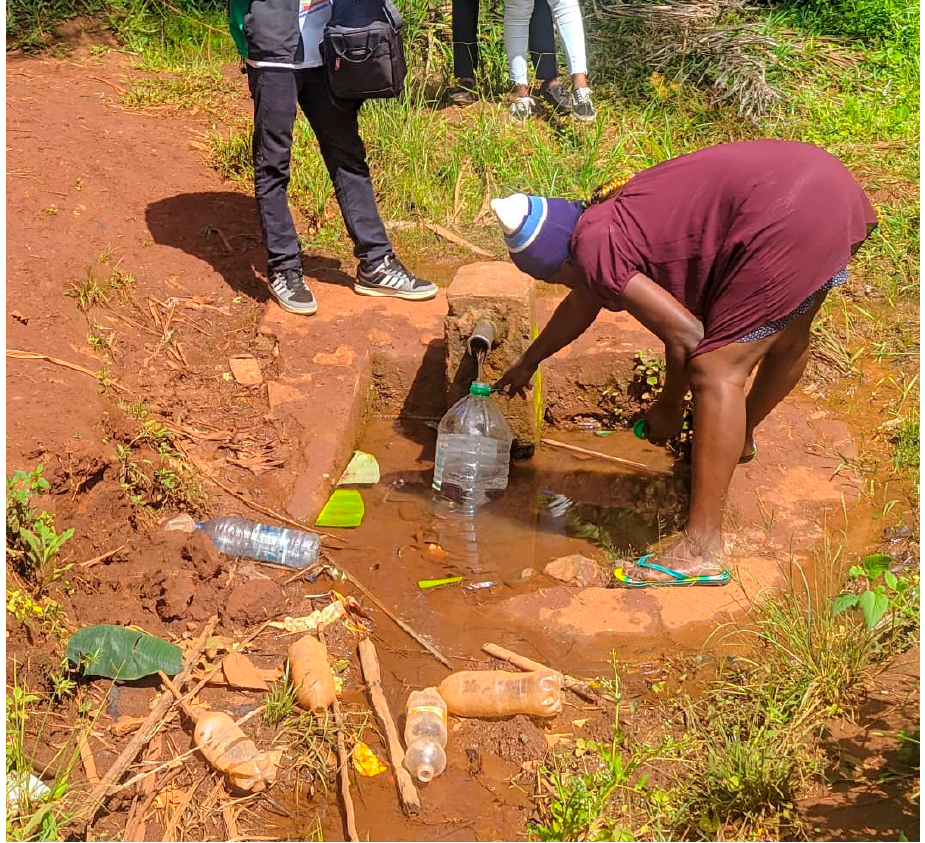
Figure 2. A lady fetching water from the historical spring of Nyamjeu. A crowded protected source in Mba on 6 October 2021. Photograph taken by Junior Fangang-Fanseu, October 2021.